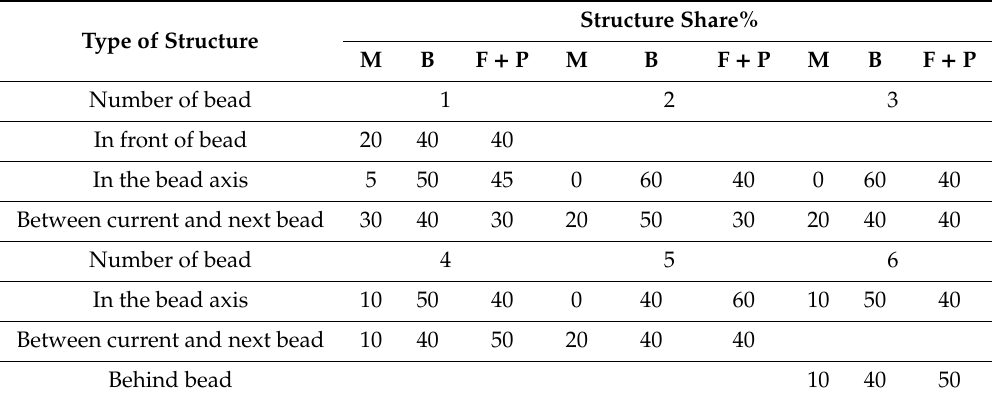
Table 4. Shares of structures in the surfaced welds on plate A.